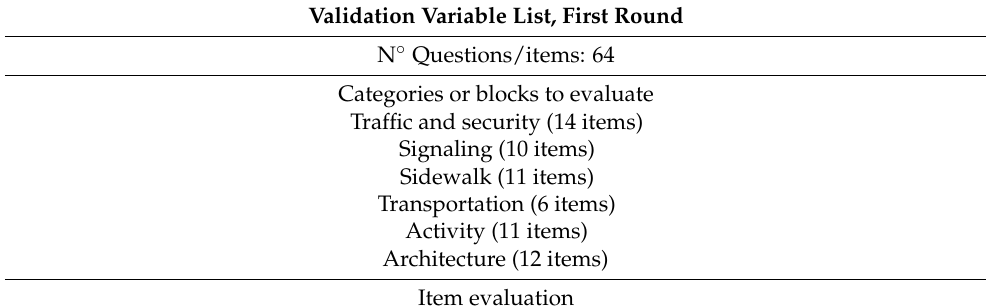
Table 4. Expert evaluation variable list